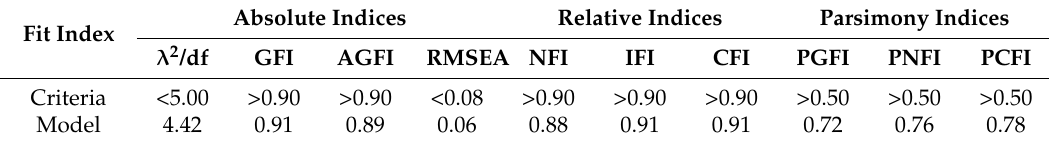
Table 3. The summary of model fit indices. Table 4. Tests of the hypotheses.